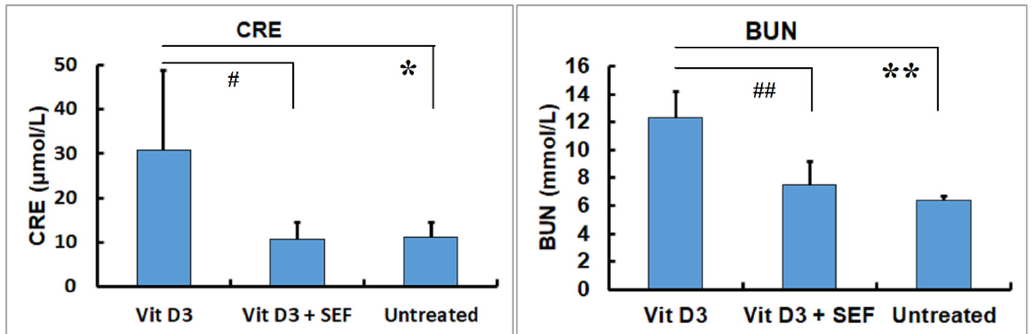
Figure 2. Serum biochemical findings in CRE and BUN concentrations. Both CRE and BUN concentrations in the Vit D 3 -treated group increase. *: Significantly different from the Vit D 3 + SEF-treated group and the untreated group ( p < 0.05). **: Significantly different from the Vit D 3 + SEF-treated group and the untreated group ( p < 0.01). # : Significantly different from the Vit D 3 + SEF-treated group and the untreated group ( p < 0.05). ## : Significantly different from the Vit D 3 + SEF-treated group and the untreated group ( p < 0.01).